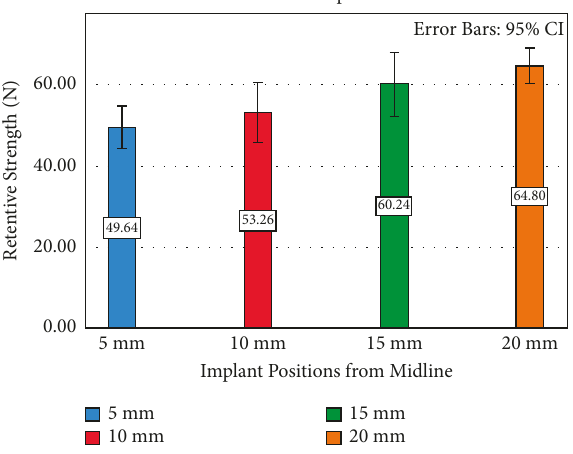
Figure 3: Retention of 2IMO with different implant positions. Table 3: Pairwise comparison of retentive strengths with different implant